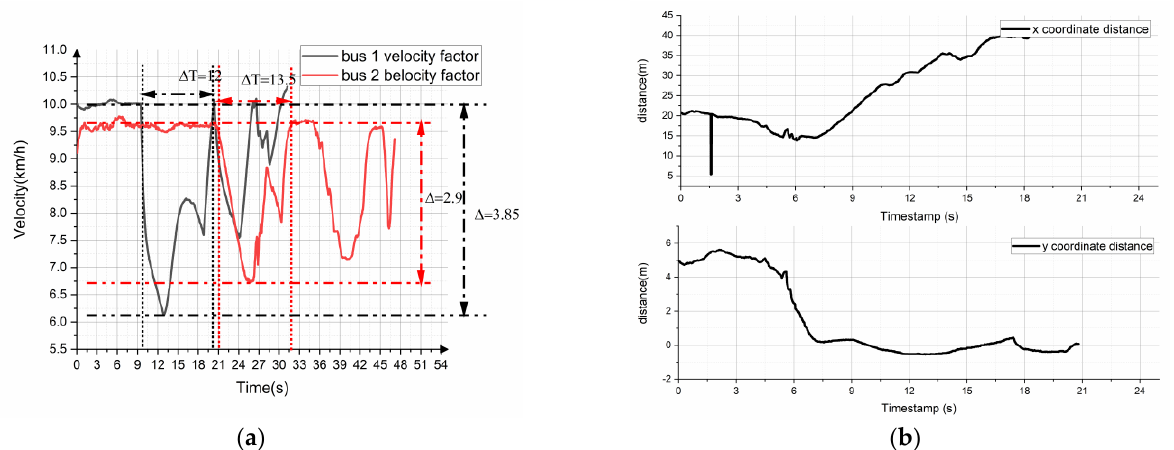
Figure 24. Speed and relative distance of real vehicle test 4: ( a ) queue vehicle speed without flexible following factor or flexible fading factor: ( b ) queue vehicle transverse–longitudinal trajectory without flexible following factor or flexible decay factor. Table 9. Comparison of evaluation parameters of four